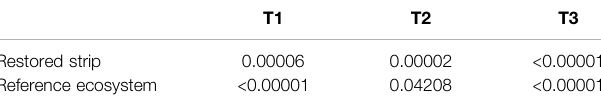
TABLE 1 | p value (95%) from paired t -test with datasets from 1-year and 3-years post-restoration [subsampling per transect: restored strip, n (cid:2) 13; reference